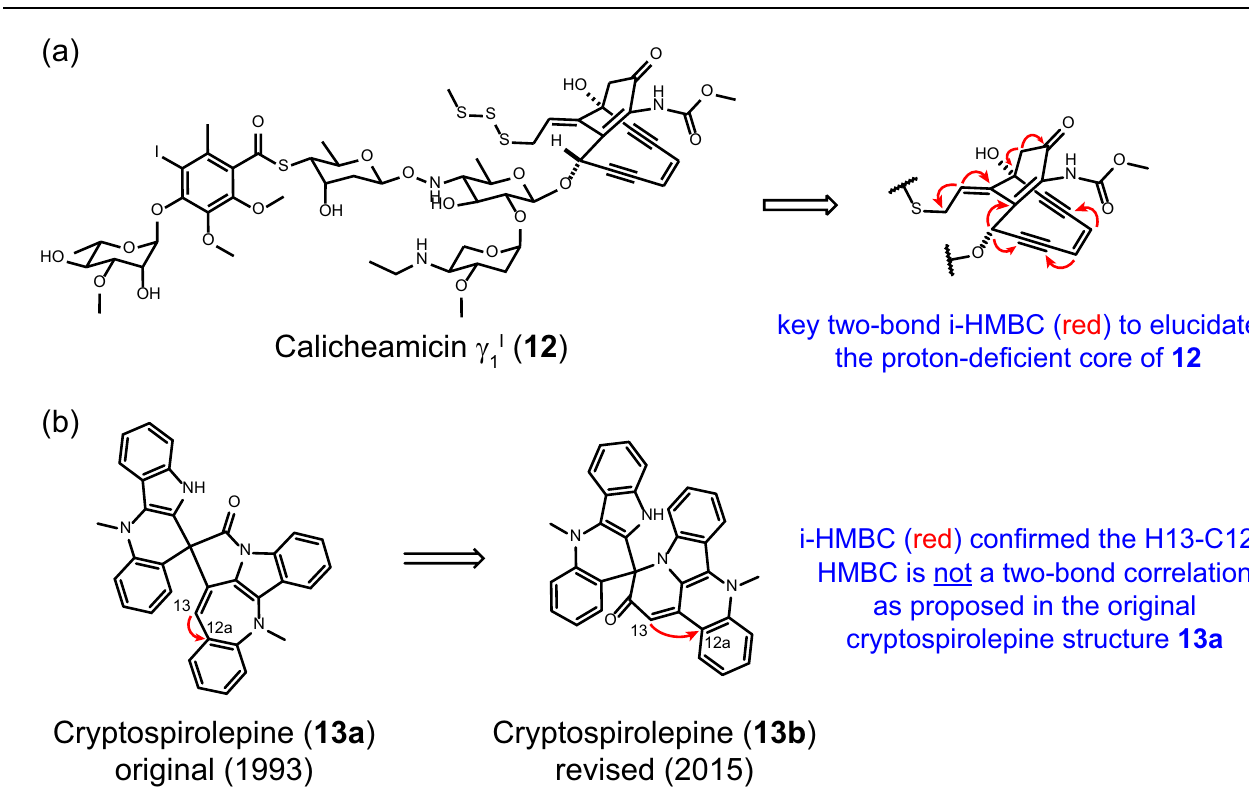
Fig.6|Applicationsofi-HMBCforstructurecon fi rmationofcomplexnaturalproducts.a Theproton-de fi cientcoreincalicheamicin γ 1 I ( 12 )and b therevisedstructure of cryptospirolepine ( 13b